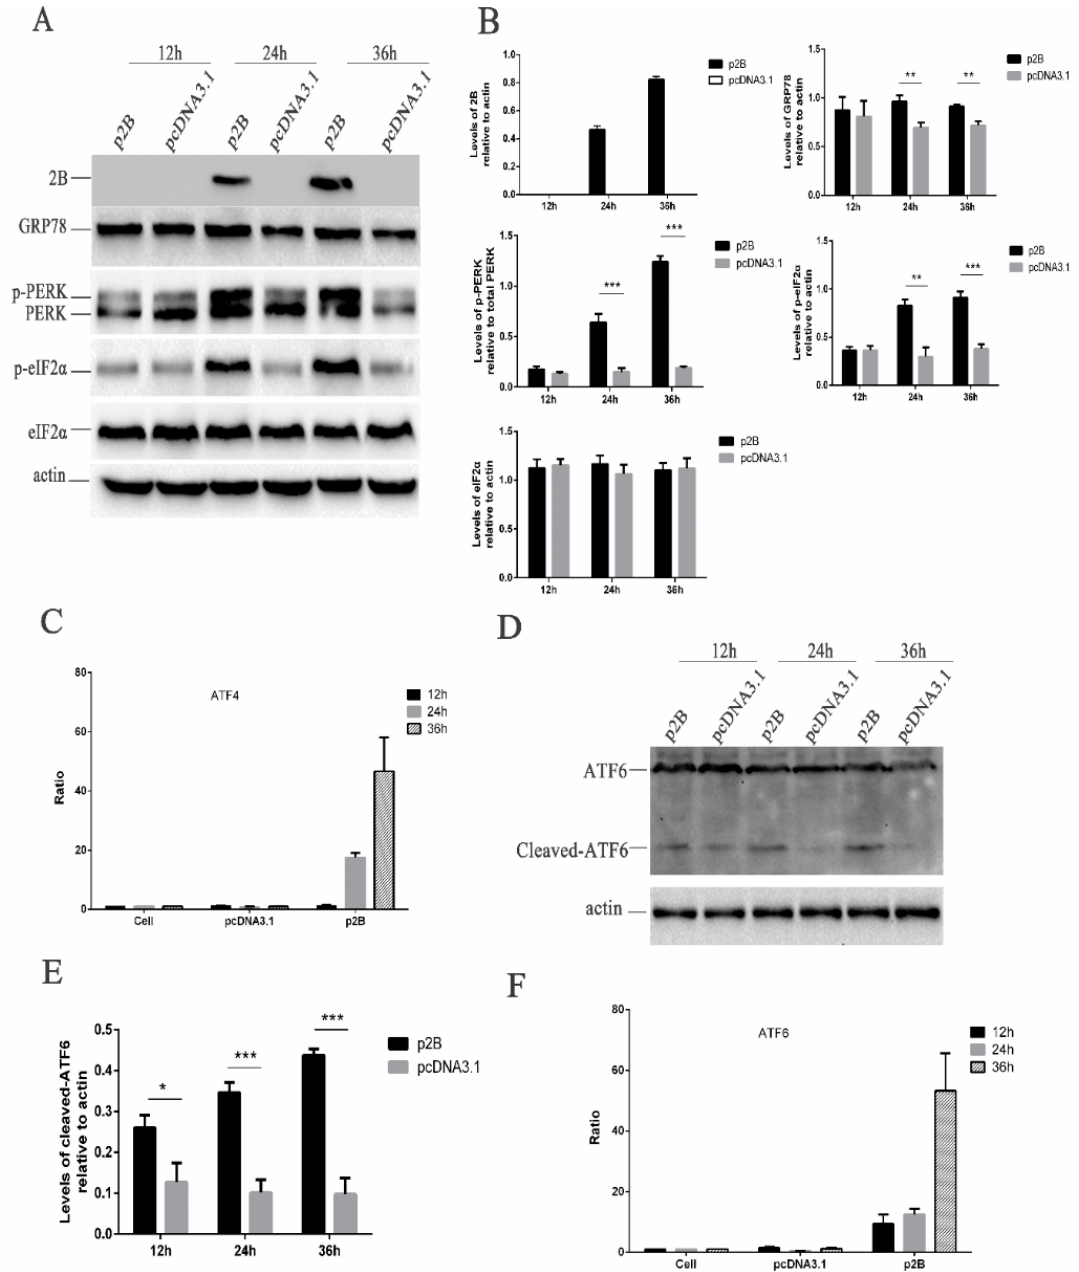
Figure 5. HRV16 2B induces ER stress through the PERK and ATF6 pathways. HRV16 2B activated the PERK–eIF2 α –ATF4 and ATF6 pathways. ( A ) H1-HeLa cells were transiently transfected with p2B or pcDNA3.1 plasmid for 12 h, 24 h and 36 h. The cells were then lysed and analyzed for the expressions of the 2B protein, GRP78, PERK (p-PERK), p-eIF2 α , eIF2 α and actin by Western blotting. ( B ) Histogram of gray scanning analyses of the 2B, GRP78, p-eIF2 α and eIF2 α protein bands of Figure 4A relative to actin is shown. The quantitative analysis of the gray value of p-PERK to total PERK is represented. The error bars represent the mean SD of three independent experiments. Statistical differences compared with the controls are illustrated as * p < 0.05, ** p < 0.01, and *** p < 0.001. ( C ) H1-HeLa cells were transiently transfected with ATF4-Luc together with p2B or pcDNA3.1. The cells were then lysed for the measurement of firefly luciferase activity. Luciferase activities are expressed as the relative value ± SD from three independent experiments. ( D ) H1-HeLa cells were transiently transfected with p2B or pcDNA3.1. The levels of ATF6 (cleaved ATF6) and actin were detected by Western